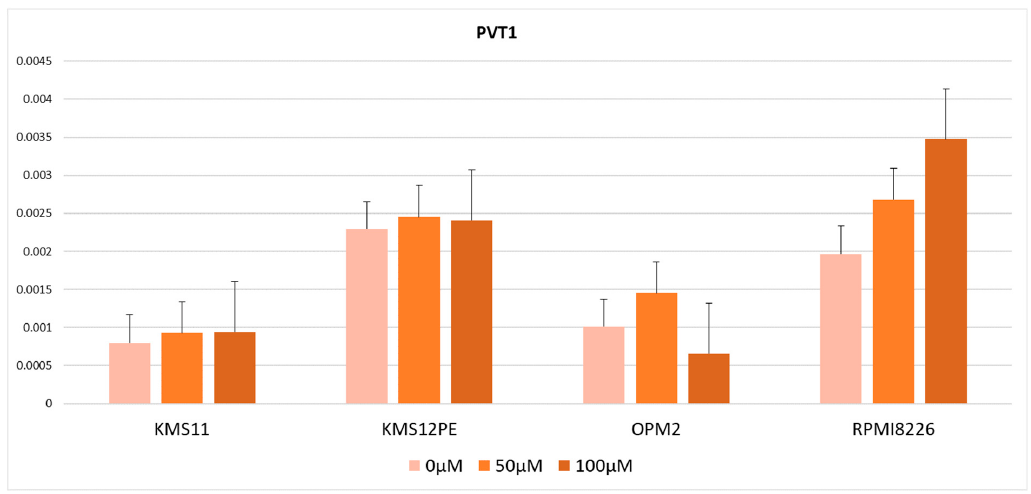
Figure 3. PVT1 expression in cells treated with the MYC inhibitor 10058-F4. Error bars show the standard error of mean (SEM).